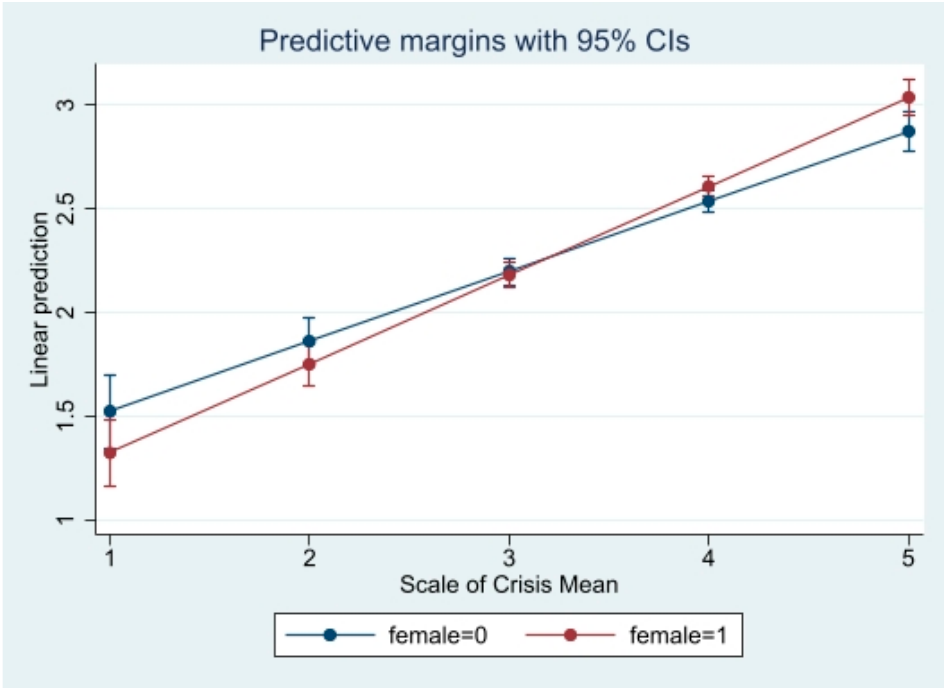
Figure 1. Predicted Coronavirus Anxiety by Crisis Perception and Gender .